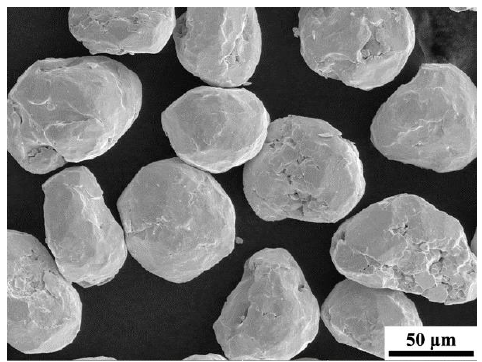
Figure 1. Morphology of the sprayed Mo powder.